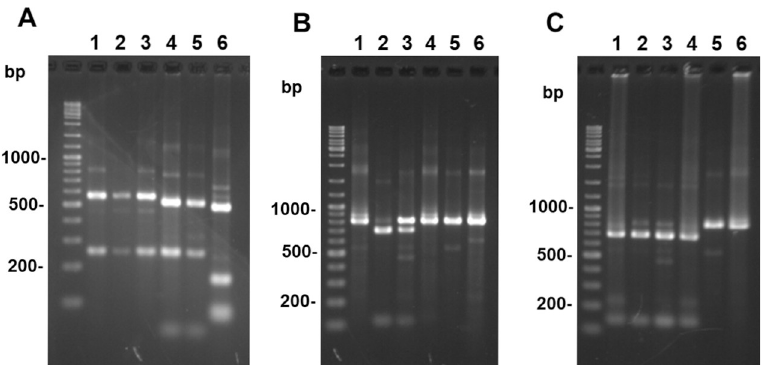
Fig 1. PCR-RFLP analyses of mpi gene fragments from 6 Leishmania species in Peru. PCR amplification was performed with leishmanial mannose phosphate isomerase ( mpi ) gene-specific primers, and PCR products were digested with Hae III (A), Vpa k11BI (B), or Bst XI (C), and resulting restriction fragment patterns were analyzed by agarose gel electrophoresis. 1. L . (V . ) braziliensis , 2. L . (V . ) peruviana , 3. a hybrid of L . (V . ) braziliensis/L . (V . ) peruviana , 4. L . (V . ) guyanensis , 5. L . (V . ) lainsoni , 6. L . (L . ) amazonensis .